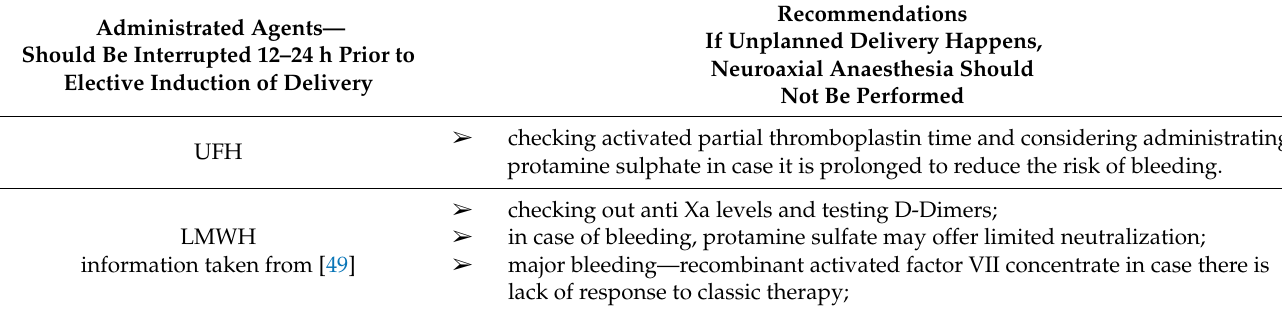
Table 2. Management at the time of